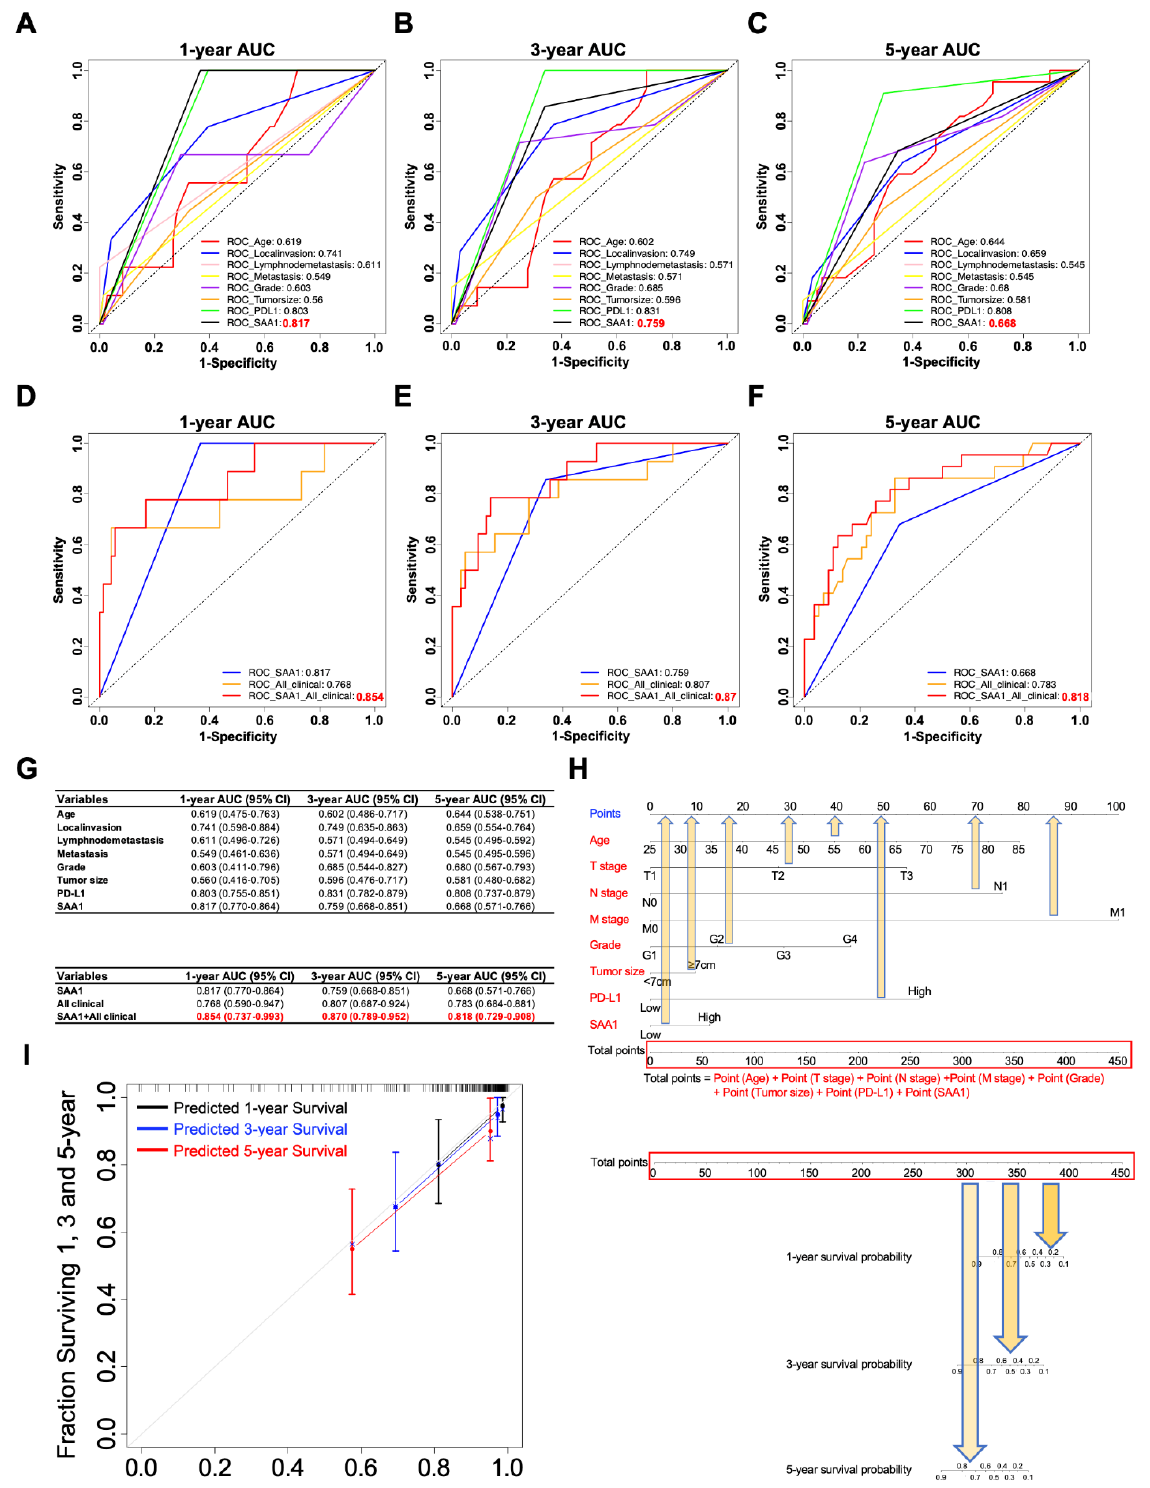
Figure 8. SAA1 as a potent prognostic factor in ccRCC. ( A – C ) Time-dependent ROC curves for as- sessing the predictive ability of SAA1 and clinicopathological features (Age, T stage, N stage, M stage, tumor grade, tumor size, PDL1 levels, and SAA1 levels) at different time points ( A ): 1 year, ( B ): 3 years, ( C ): 5 years in ccRCC. ( D – F ) Comparisons of the prognostic accuracy between SAA1, all clinicopathological features and combination of all clinicopathological features and SAA1 levels.